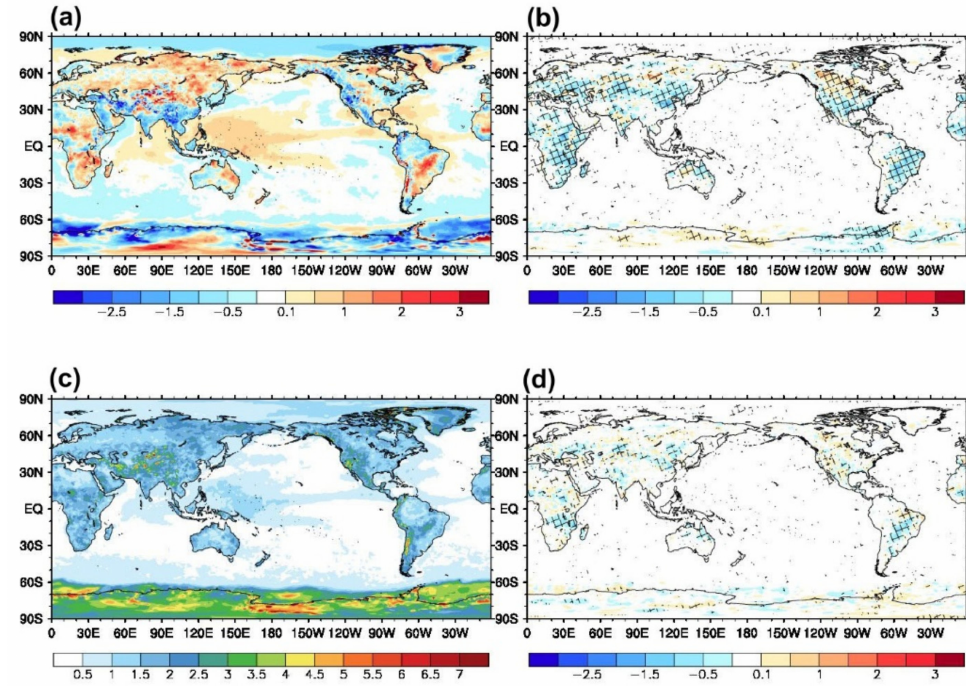
Figure 7. ( a ) Biases and ( c ) RMSEs of 2-m air temperature in the CTL against the ERA5 reanalysis, and ( b ) differences in the biases and ( d ) RMSEs between the EXP and CTL over the period of 1 July 2019 to 10 August 2019 for the analysis field. The hatched regions indicate a difference significant at the 95% confidence